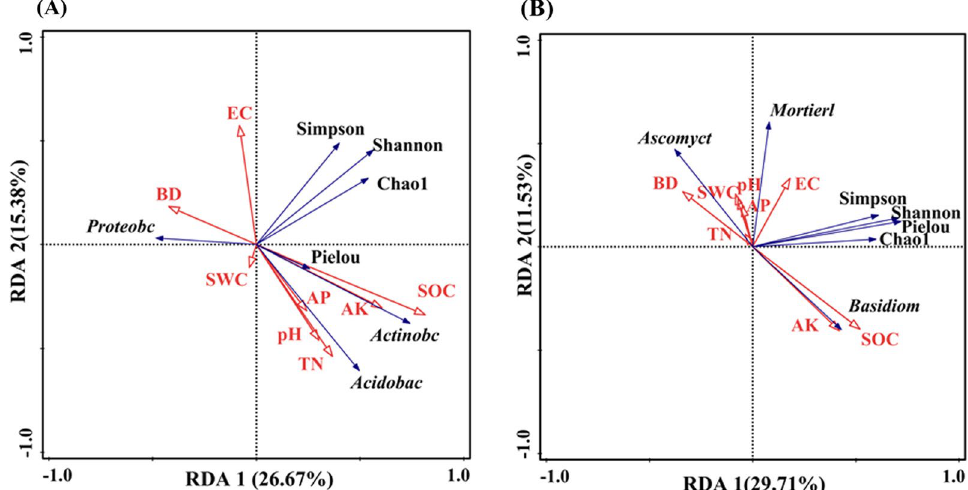
Fig. 5 Redundancy analysis (RDA) of the relationships between soil microbial community composition, alpha diversity indices at the phylum level and physicochemical properties. A Bacteria; B